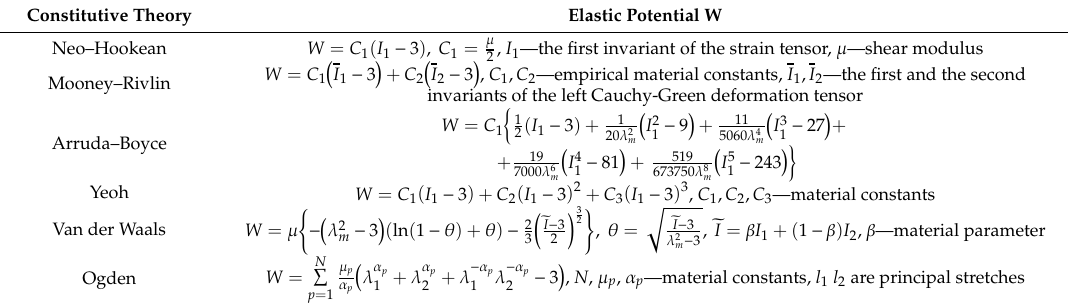
Table 1. Elastic potentials for the selected hyper-elastic constitutive